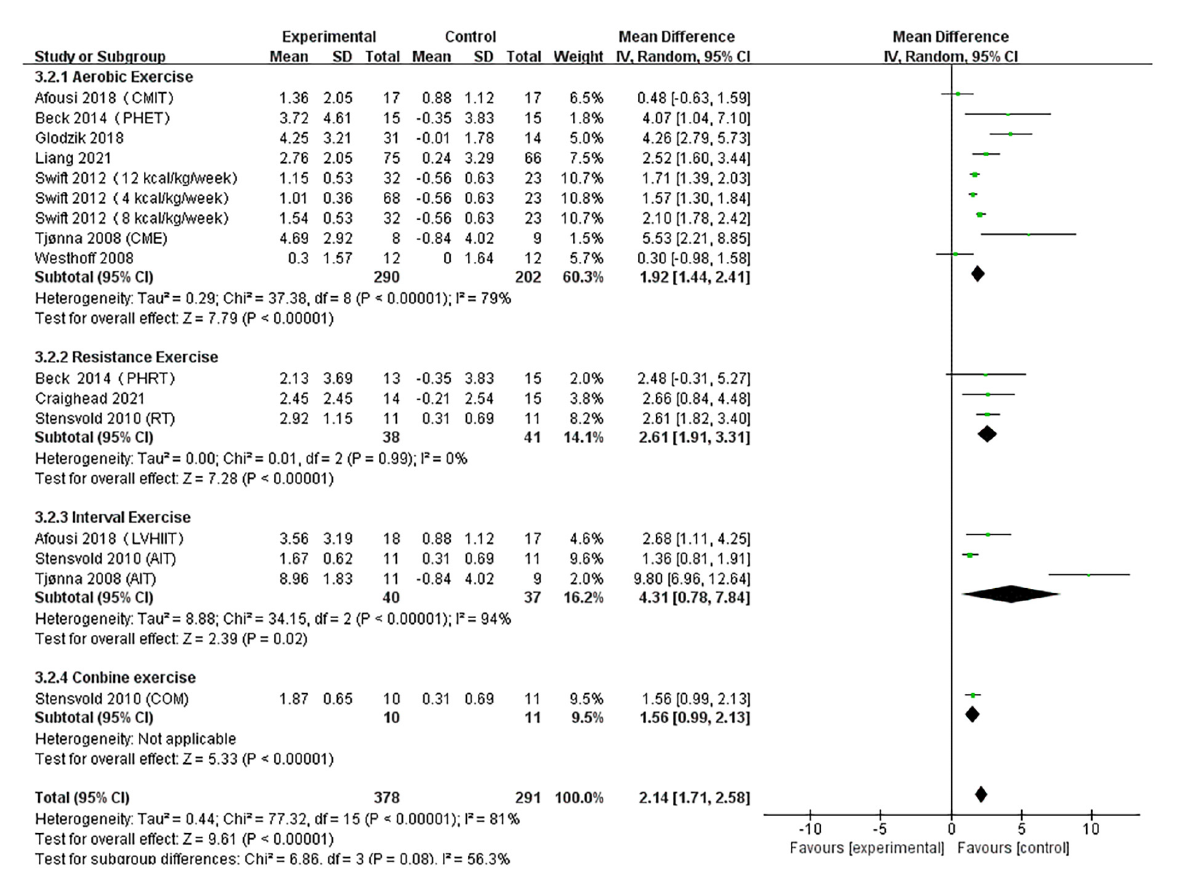
FIGURE5 Forest plot of postintervention FMD-value comparison between exercise and control groups. SD, standard deviation; Std, standardized; IV, inverse variance; CI, confidence